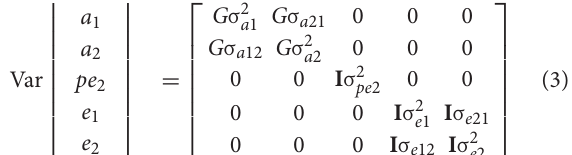
for lipid content in European seabass was developed in an independent calibration set, we make the distinction that the root mean square error estimated herein is actually a root mean square error of prediction (RMSEP) and therefore, a good estimator on the error on measurement to be expected in independent populations. The RMSEP ranged from 1.9 to 2.1% within and seen by the CCC ranging from 0.36 in the 2016 cohort to 0.63